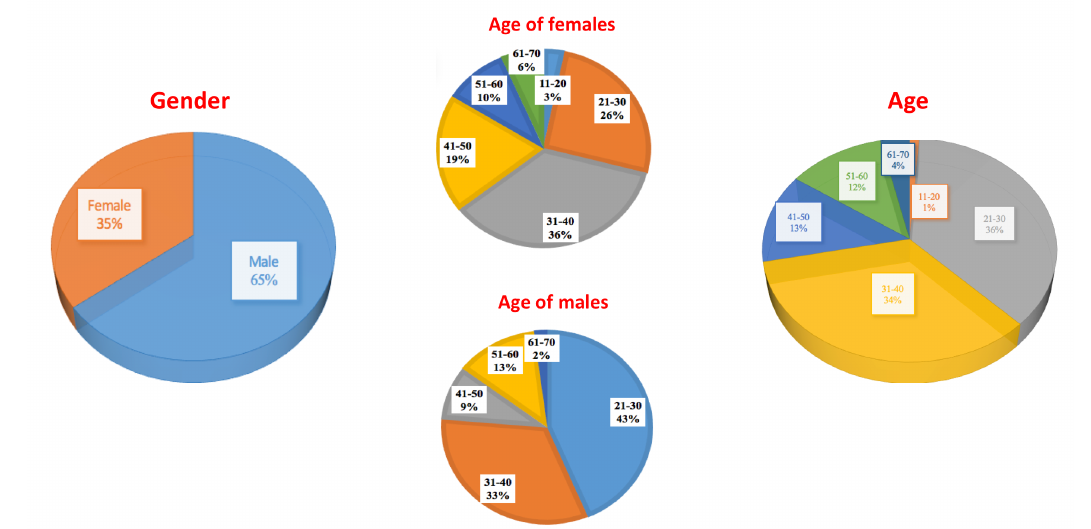
Figure 2. Graphics showing the most important features of the subjects included in 3DWF dataset: age and